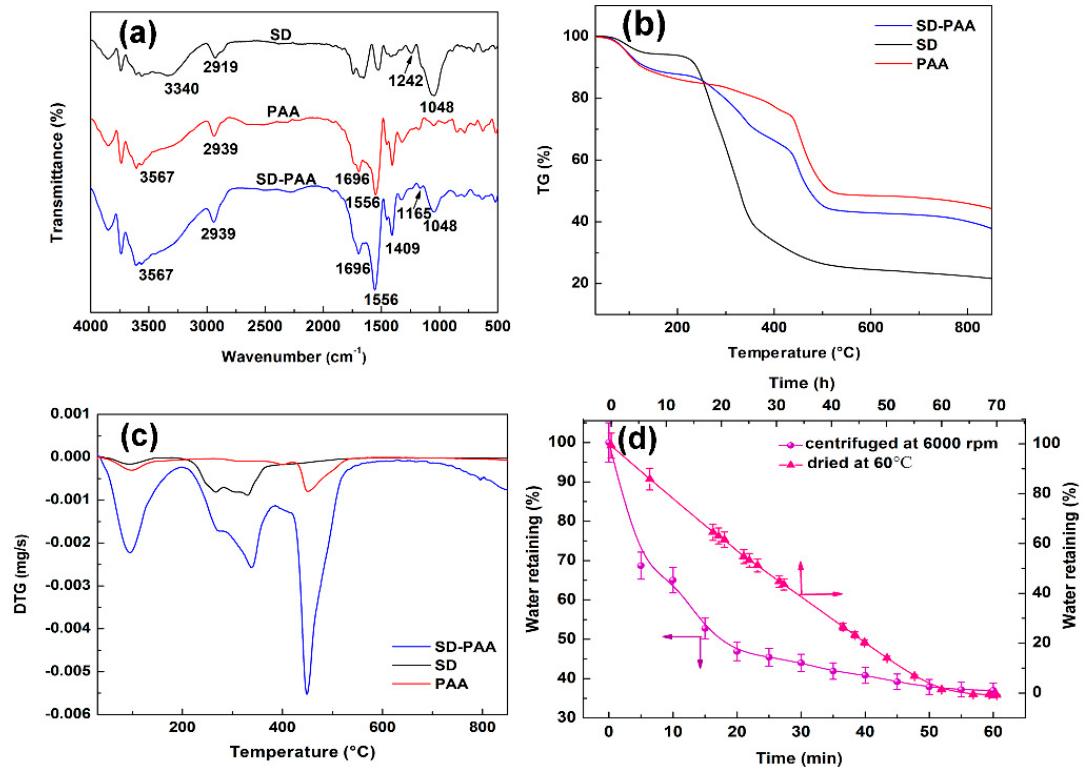
Figure 3. ( a ) FTIR spectra of SD, PAA and SD-PAA; ( b ) Thermogravimetric (TG) curves of SD, PAA, and SD-PAA; ( c ) DerivativeThermogravimetry (DTG) curves of SD, PAA, and SD-PAA, and ( d ) Water retaining of SD-PAA.